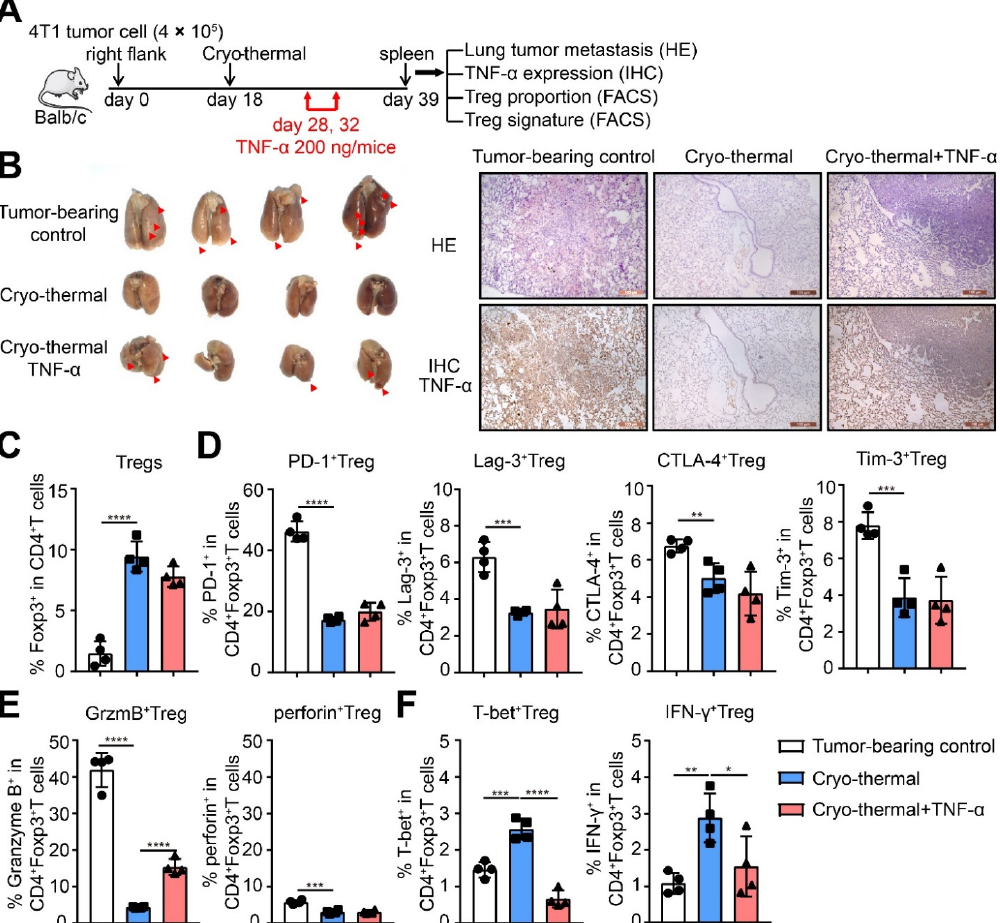
Figure 5. In vivo TNF- α supplement after cryo-thermal therapy damaged Tregs fragility and promoted tumor metastasis of mice. ( A ) Schematic of experimental design. For TNF- α supplement in vivo, 200 ng recombinant TNF- α protein was injected intraperitoneally in 100 μ L PBS on day 10 and 14 after cryo-thermal therapy. ( B ) Photographic images of lungs (left), HE staining (upper-right) and IHC staining of TNF- α (brown, lower right) from tumor-bearing control (39 days after inoculation), cryo-thermal treated or TNF- α supplied after cryo-thermal therapy mice (21 days after treatment). ( C – E ) The proportion of Tregs ( C ), the expression of inhibitory checkpoints ( D ), the expression of suppressive cytokines ( E ), and the expression of T-bet and IFN- γ ( F ) of Tregs were detected on day 21 after single cryo-thermal, or combined with TNF- α supplement by flow cytometry. n = 4 for each group. * p < 0.05, ** p < 0.01, *** p < 0.001, **** p < 0.0001. Next, we determined the proportion and suppressive signature of Tregs after cryo- thermal therapy with TNF- α supplementation. TNF- α supplementation after cryo-ther- mal therapy had less effect on the proportion of Tregs and the expression of PD-1, Lag-3, CTLA-4, and Tim-3 on Tregs than cryo-thermal therapy alone (Figure 5C,D). However, the expression of Granzyme B on Tregs was significantly upregulated, and the expression of perforin had no change after cryo-thermal therapy with TNF- α supplementation (Fig- ure 5E). Interestingly, TNF- α supplementation after cryo-thermal therapy downregulated the expression of T-bet and IFN- γ on Tregs compared to cryo-thermal therapy alone (Fig- ure 5F). To further confirm the effects of TNF- α on the function of Tregs after cryo-thermal therapy, splenic CD4 + T cells from tumor-bearing control (39 days after inoculation) or cryo-thermal treated mice (21 days after treatment) were isolated and cultured in vitro.